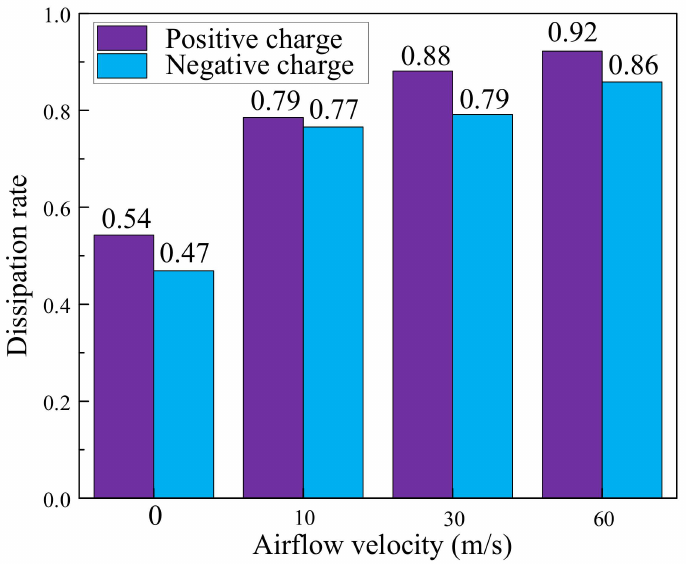
Figure 21. The variation law of airflow velocity on the average dissipation rate of positive and negative polar charges.